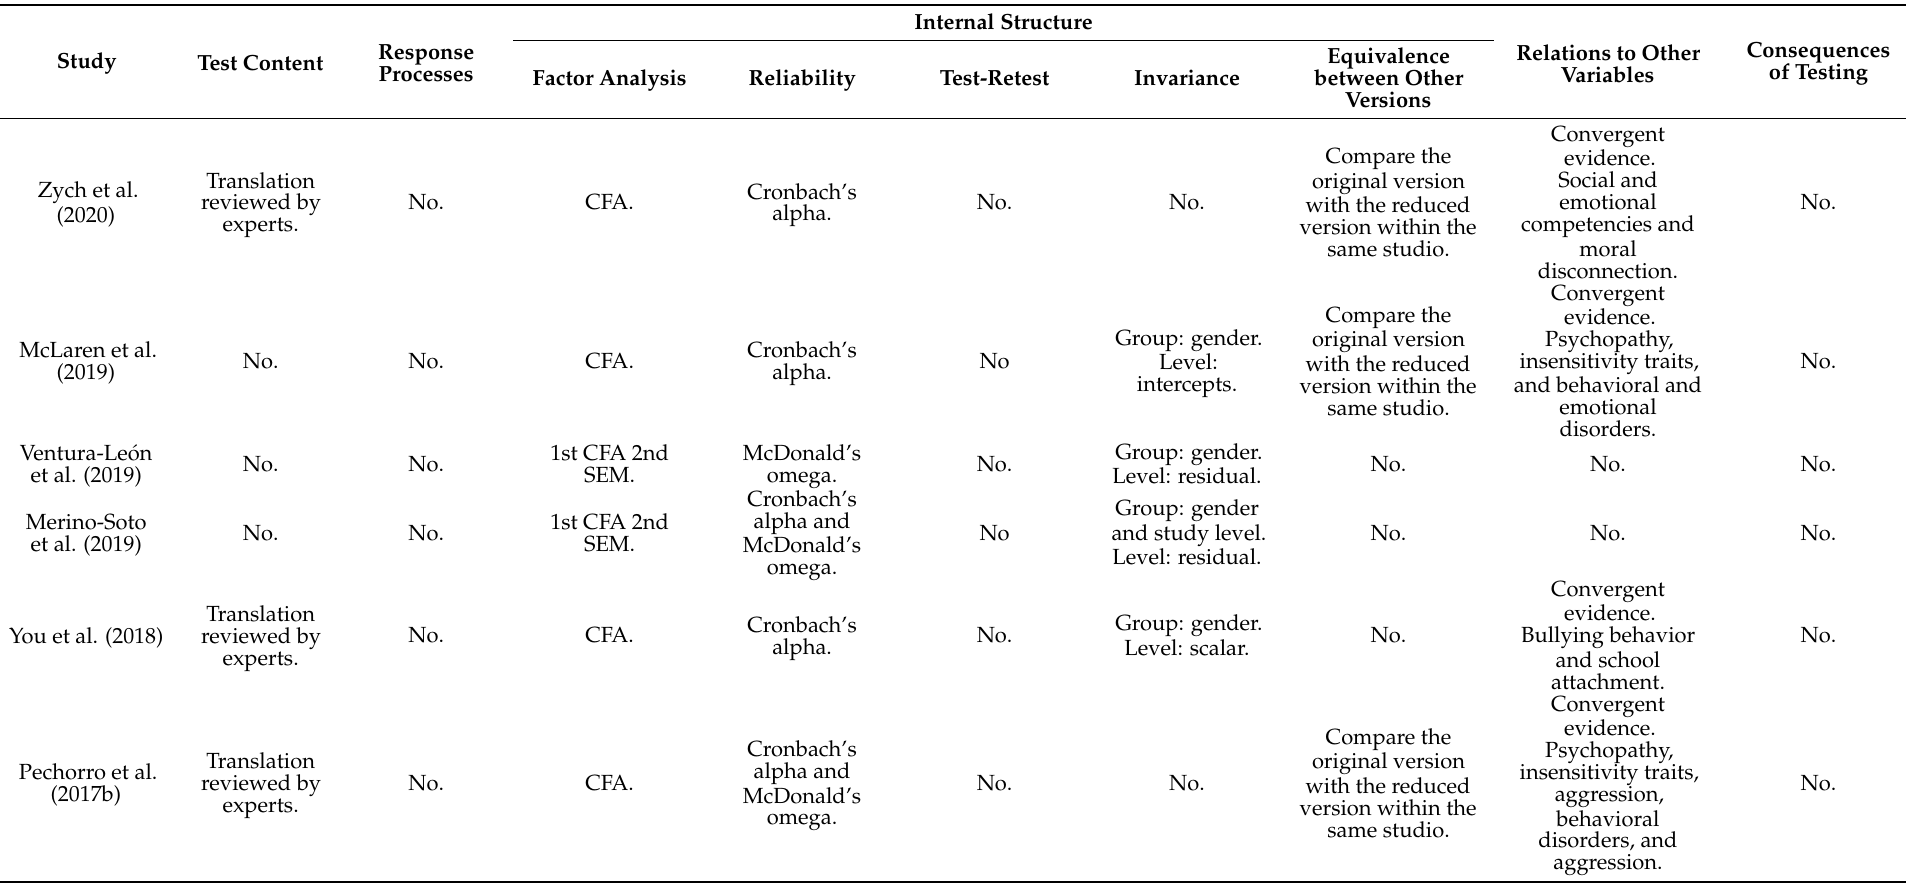
Table A1. Results of validity